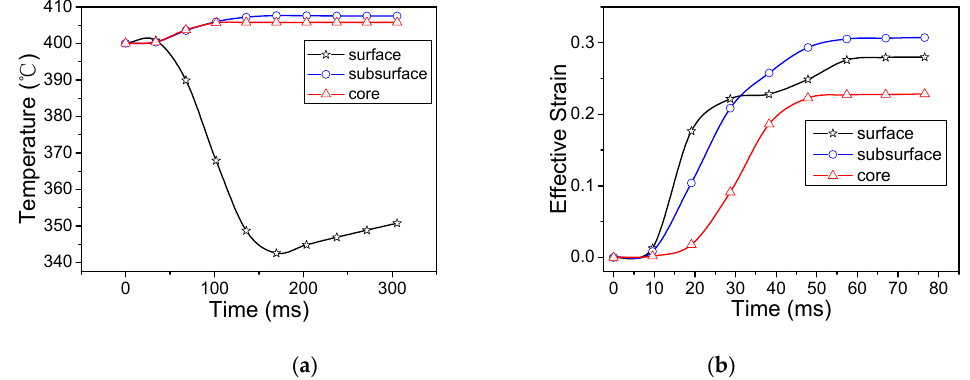
Figure 6. Distribution of temperature and equivalent strain of different layers of plate during the rolling process. ( a ) Temperature; ( b ) effective strain.